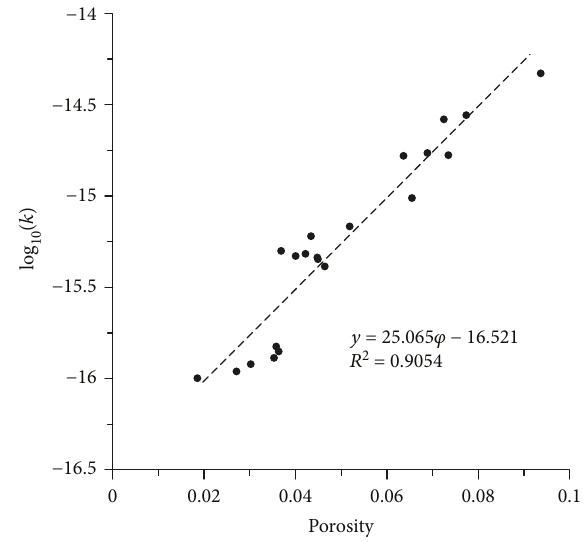
Figure 5: The relationship between permeability and porosity of dolomite in Wumishan Formation of typical geological